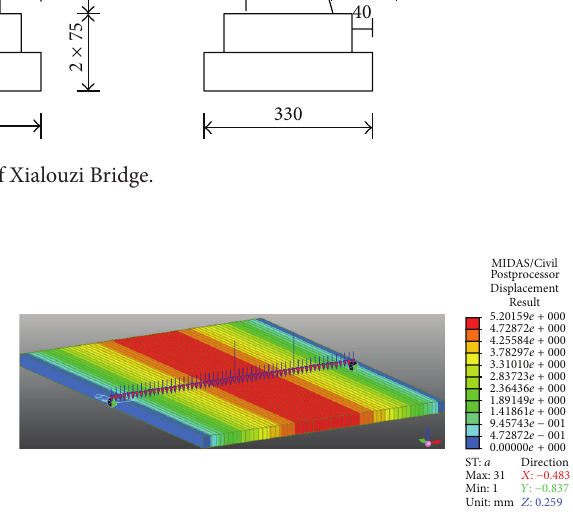
Figure 5: Calculation result of compressive stress.